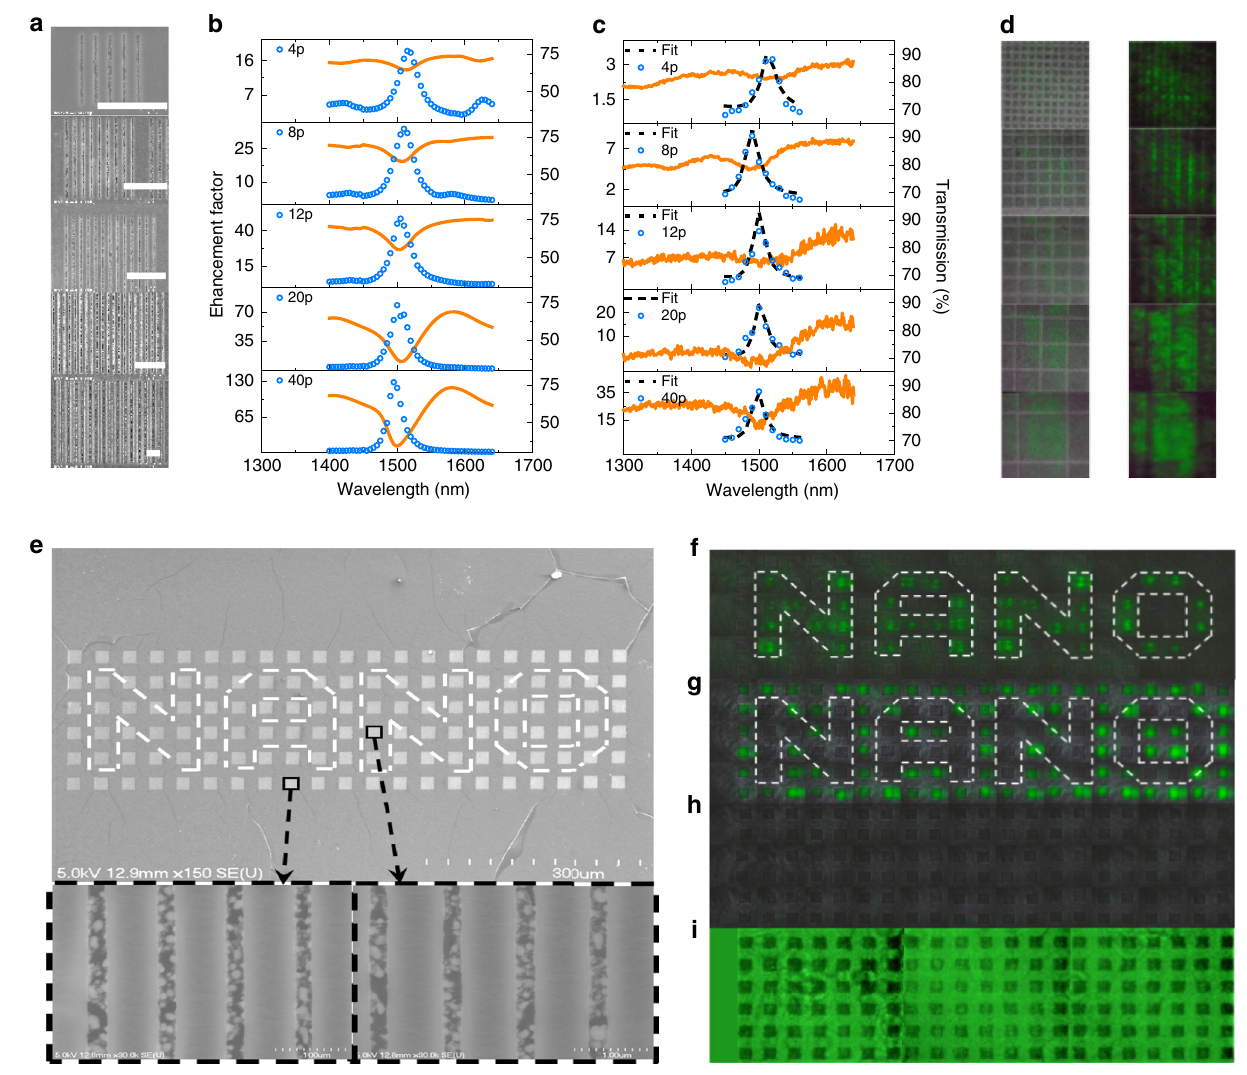
Fig. 5 The nonlinear metasurfaces for color nanoprinting and optical encryption. a The top-view SEM images of perovskite metasurfaces with different period numbers, scale bar is 5 μ m. b and c are the corresponding simulated and experiment transmission spectra and enhancement factors of three-photon luminescence. d The microscope images and the corresponding three-photon fl uorescent microscope images of perovskite metasurfaces. e The top view SEM images of the designed metasurface for nonlinear imaging, scale bar is 300 μ m. The insets are the high-resolution SEM images of the encoded information and the background, scale bar is 1 μ m. Their size parameters are l = 960 nm and l = 900 nm, respectively. The width of perovskite strip is w = l − 300 nm. f – i are the corresponding nonlinear photoluminescence images under different pumping wavelengths at 1500, 1400 and 1350 nm, and linear photoluminescence image pumped by a laser at 400